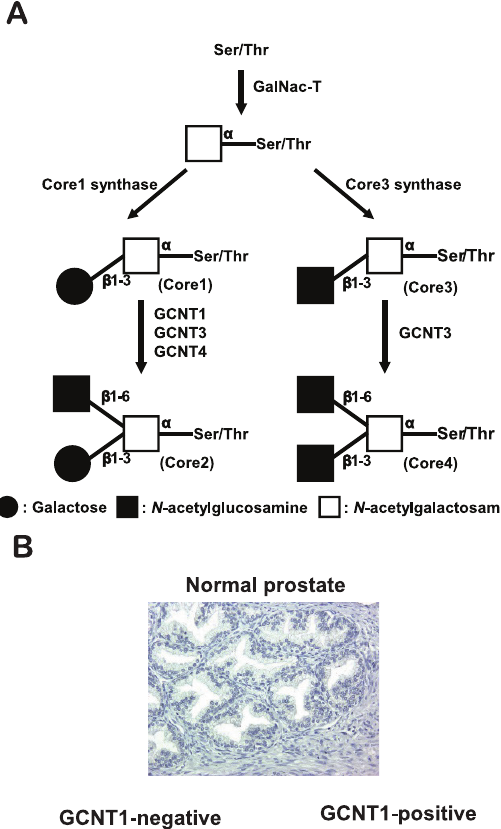
Fig 1. Core2 β -1,6- N -acetylglucosaminyltransferase-1 expression correlates with prostate cancer progression. ( A ) Biosynthetic pathways for O -glycans. ( B ) PCa specimens were incubated with an anti- core2 β -1,6- N -acetylglucosaminyltransferase-1 (GCNT1) monoclonal antibody (mAb), followed by a horseradish peroxidase (HRP)-conjugated secondary antibody. Counterstaining was performed using hematoxylin. GCNT1-positive cancer cells are brown. ( C ) Prostate-specific antigen-free survival periods were